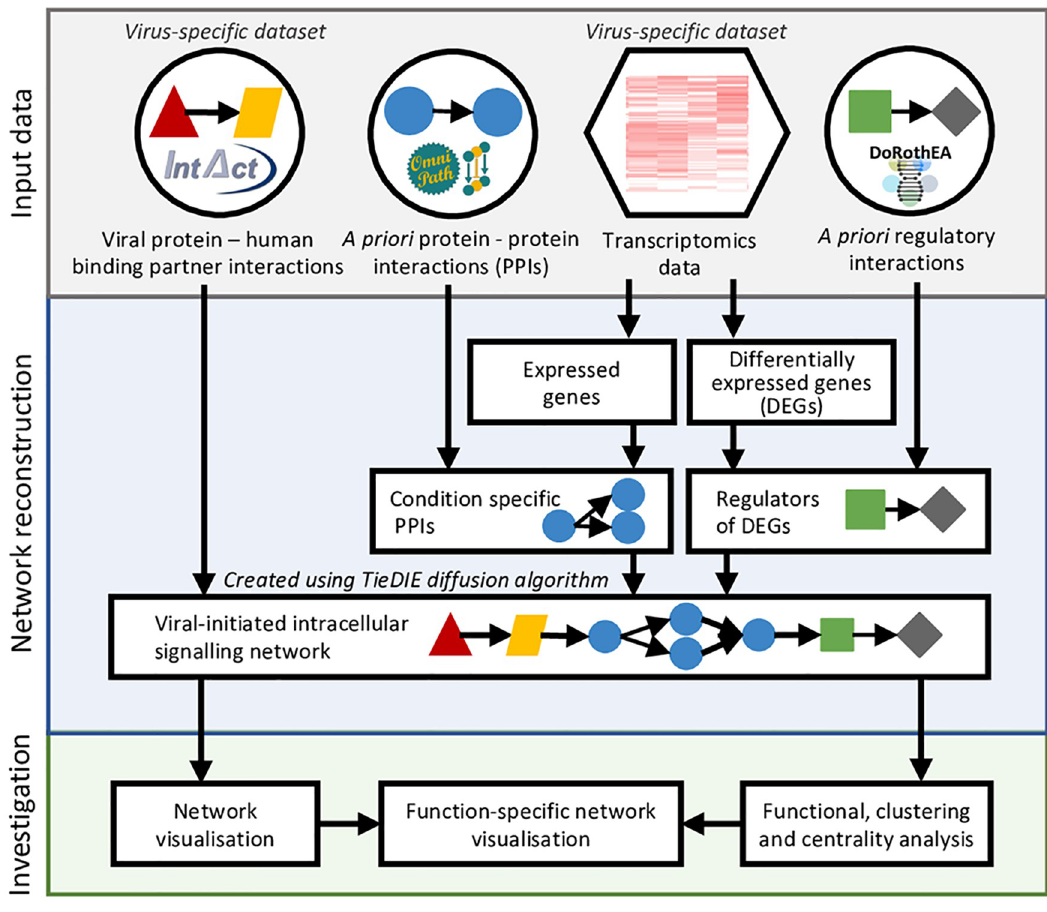
Fig 1. ViralLink workflow